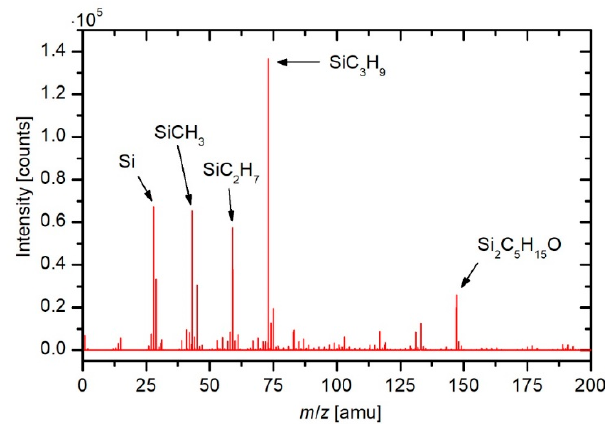
Figure 9. ToF-SIMS spectrum of positive secondary ions emitted from the surface of the deposited sample.